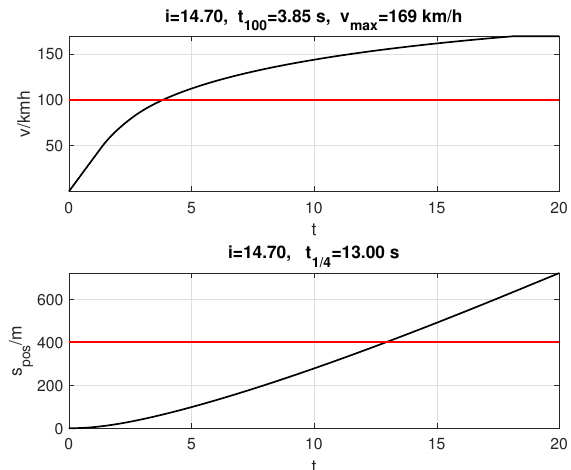
Figure 9. Optimized gear ratio i of EV for J = t 100